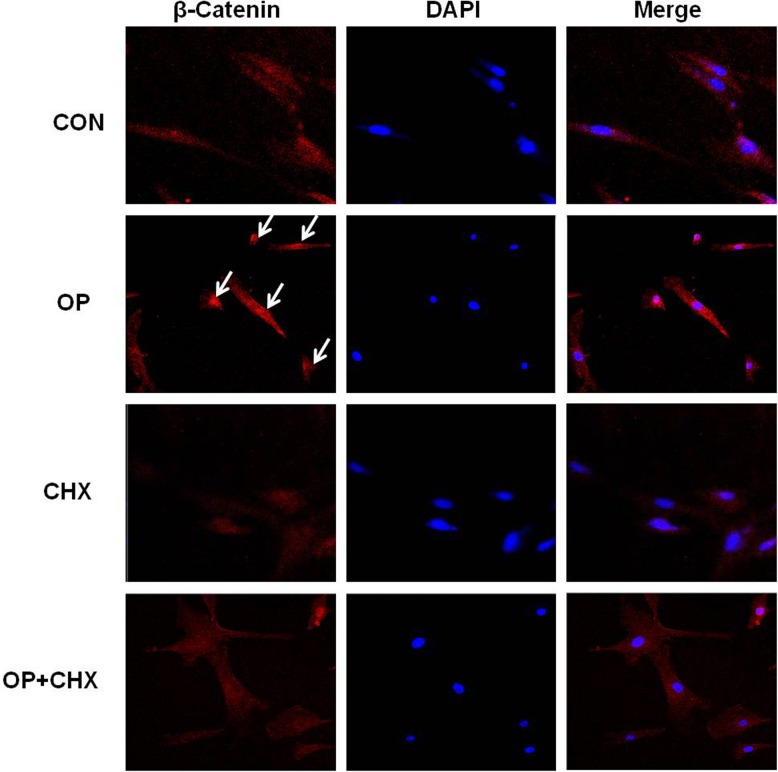
Effects of cycloheximide on β-catenin accumulation in the nucleus of DPCs induced by oleuropein treatment.DPCs were allowed to attach overnight and then treated (60 min) with cycloheximide (10 μg/ml) and thereafter switched to medium with or without oleuroepin (20 μM) in the presence of cycloheximide (10 μg/ml) for 24 h. Then cells were stained for β-catenin immunofluorescence (red) and counterstained with DAPI (blue). Merged image of β-catenin-rhodamine and DAPI staining is also shown. Original magnification: 20×.